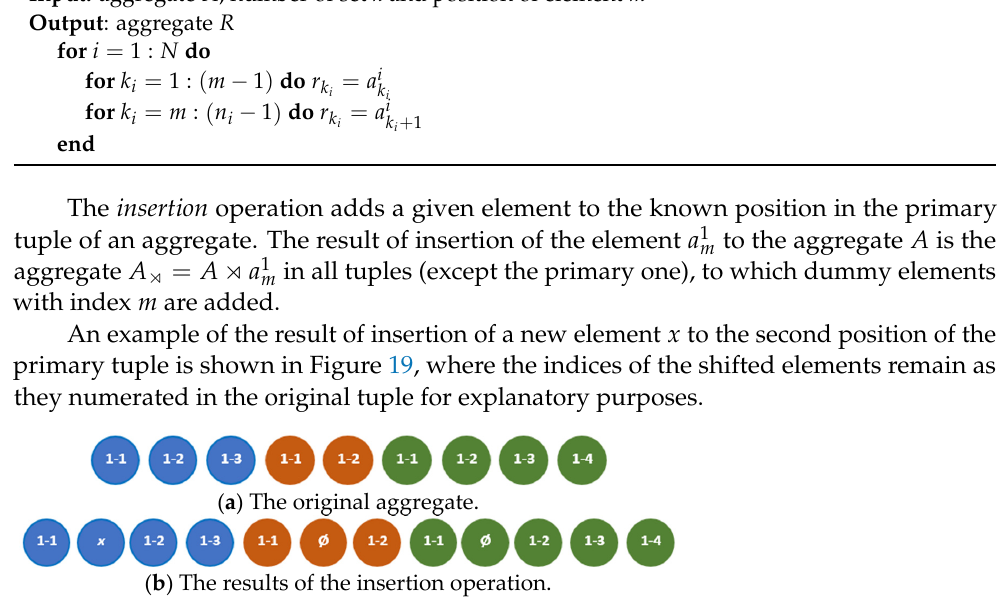
Figure 19. An example of applying the insertion